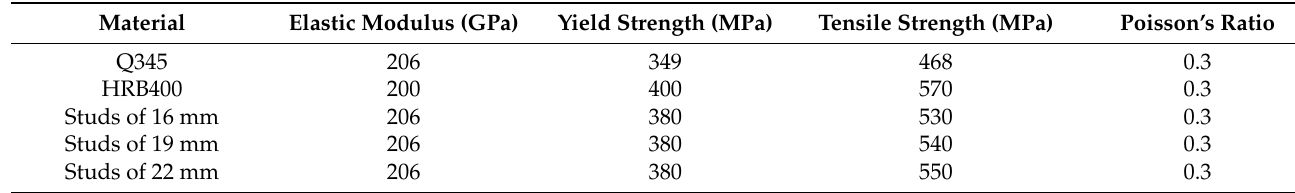
Table 4. Mechanical performance of steel.